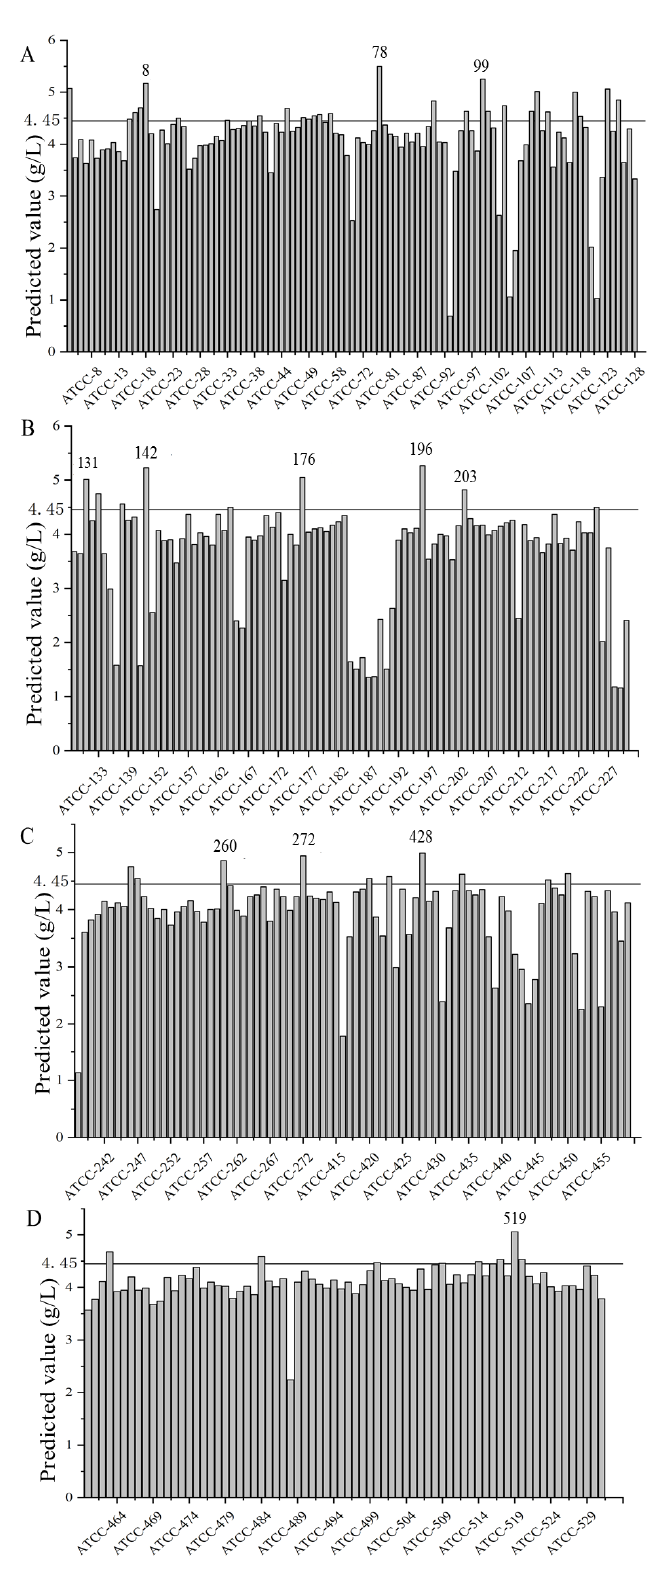
Figure 3. The predicted yield of gellan gum from mutant strains induced by ARTP. ( A ) the mutant strain 1 ‐ 128; ( B ) the mutant strain 129 ‐ 230; ( C ) the mutant strain 238 ‐ 276, 415 ‐ 459; ( D ) the mutant strain 460 ‐ 531.